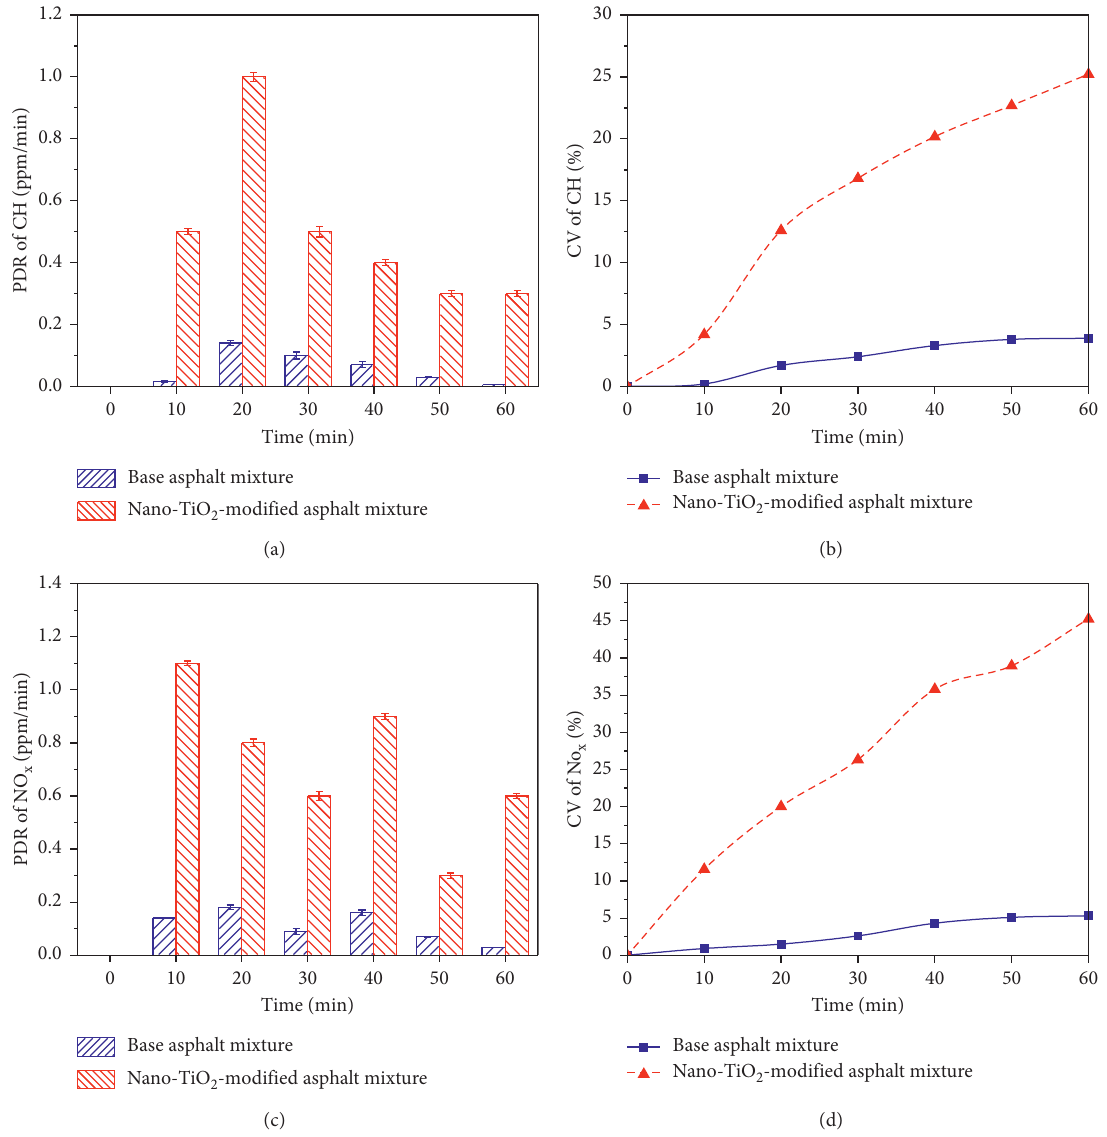
Figure 11: Photocatalytic degradation test results of automobile exhaust for asphalt mixtures with and without nano-TiO (b) CV of CH. (c) PDR of NO x. . (d) CV of NO x